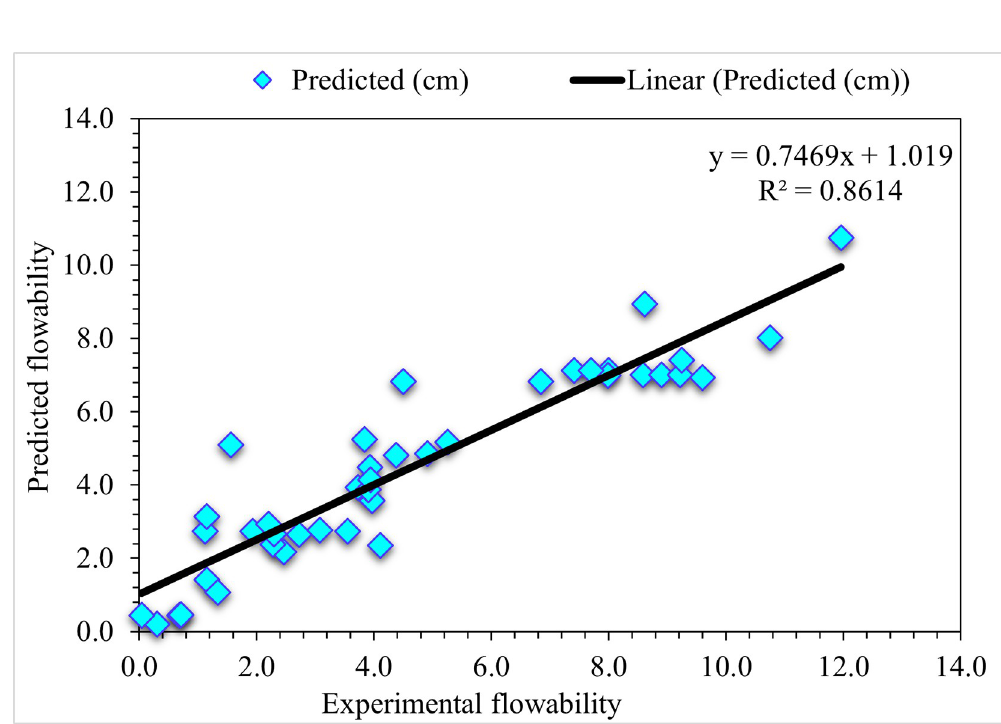
Fig 12. BA predicted and experimental values—UHPC flowability.